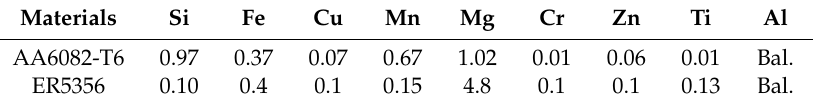
Figure 1. Groove geometry of the welding specimens. Table 1. Chemical composition of the base material and filler wire (wt. %).